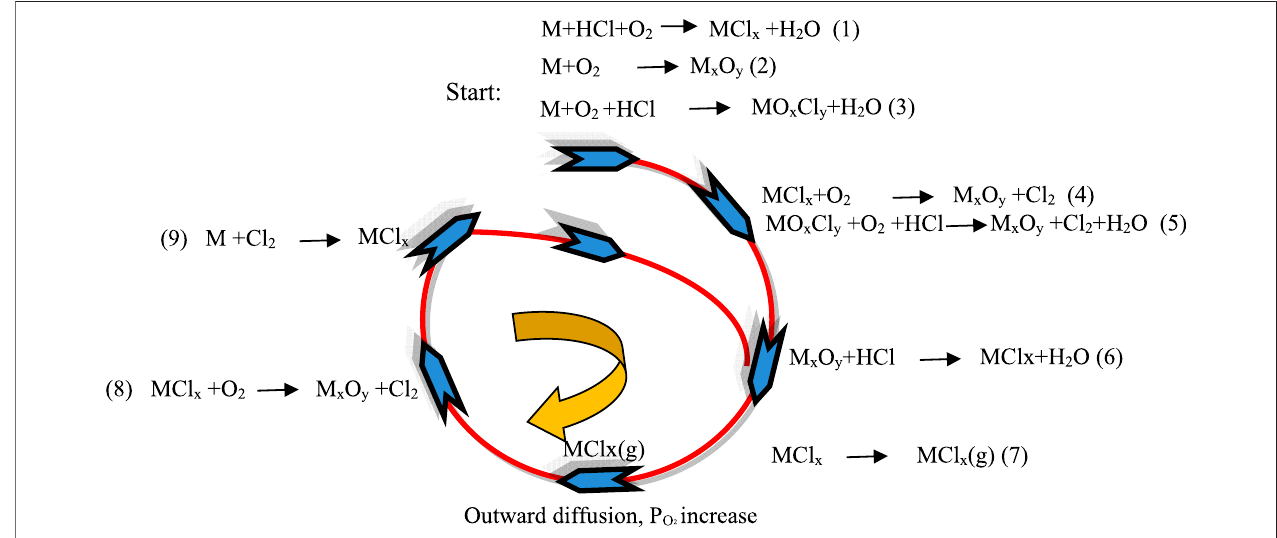
FIGURE 7 | High-temperature chloride corrosion process of metals.